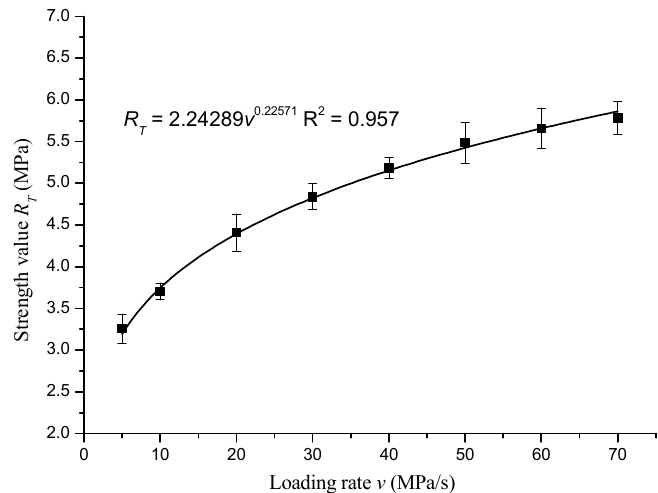
Figure 4. Indirect tensile strength curve of asphalt mixture with loading rate.